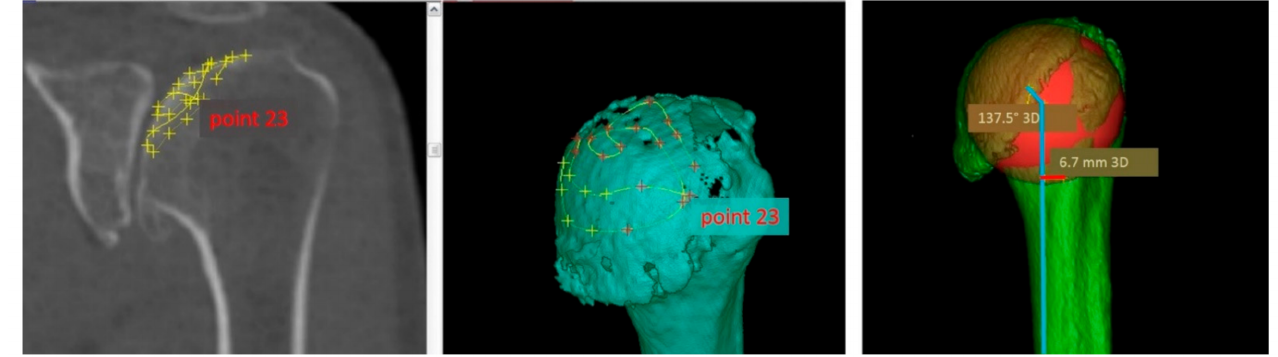
Figure 2. Scatter diagram of the articular humeral head surface. Based on these marks, the software created a three-dimensional humeral head coordi- nate system (Figure 3).